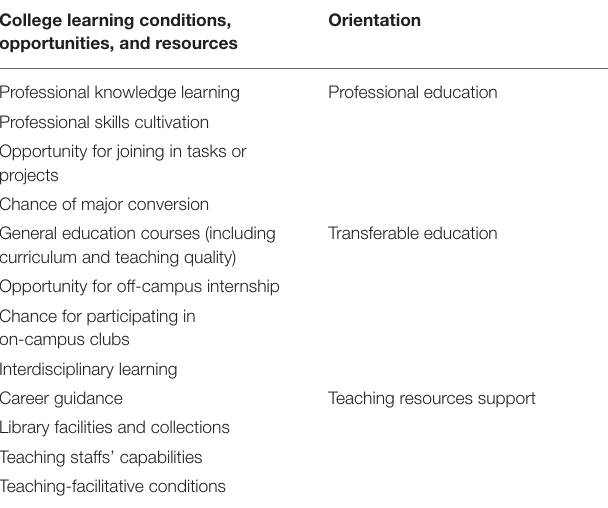
TABLE 4 | Exploratory factor analysis for educational practice.